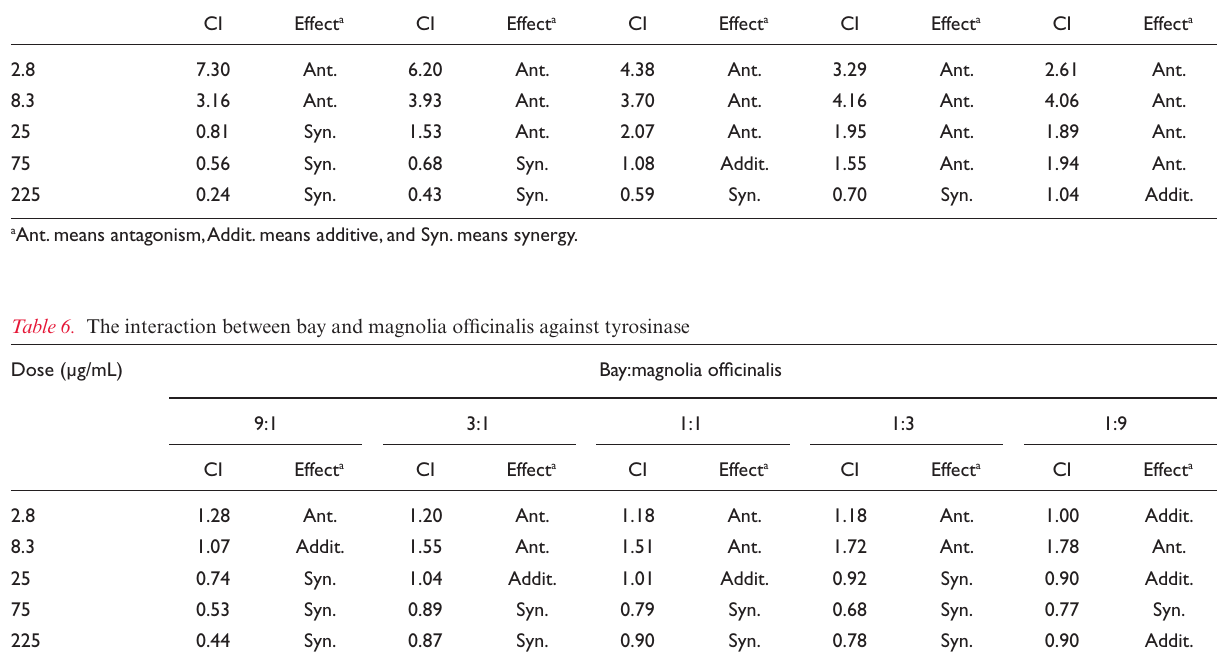
Table 5. The interaction between cinnamon and magnolia officinalis against tyrosinase Dose (μg/mL)